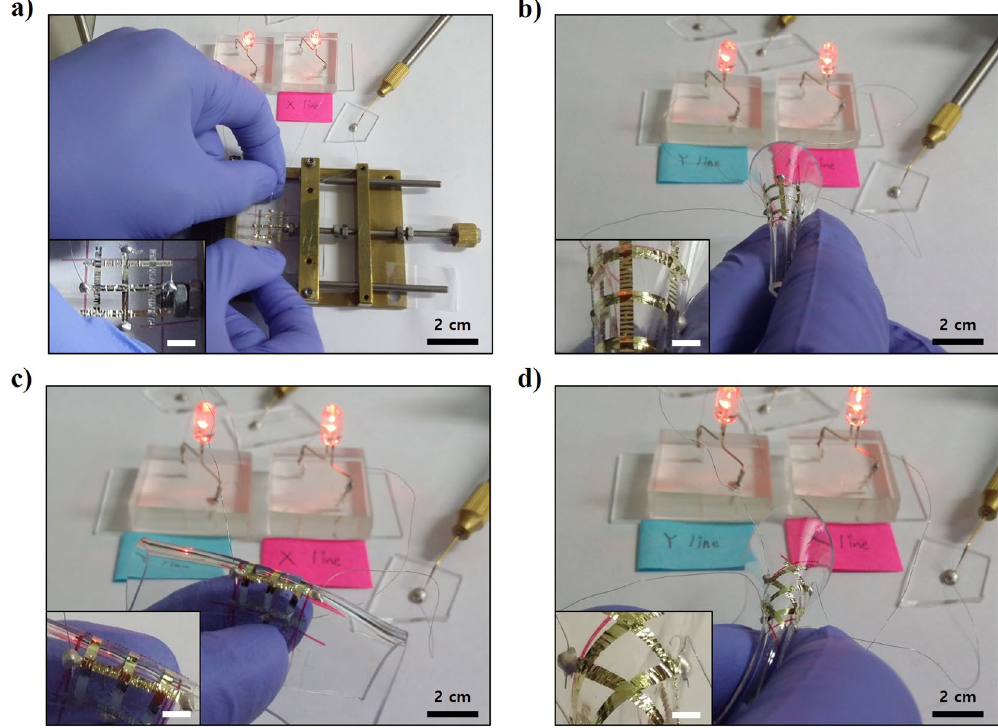
Figure 4. Photographs of LEDs connected to the cross-buckled aluminum electrodes. LEDs in the left and right side were connected to the cross-buckled aluminum electrode in the vertical and horizontal directions, respectively. Continuous LED lighting observed during ( a ) biaxial stretching and bending in the ( b ) y-axis, ( c ) x-axis, and ( d ) diagonal